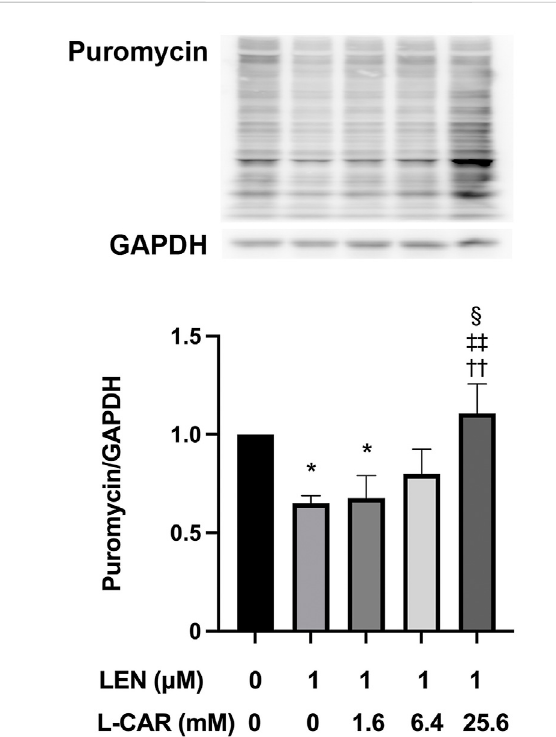
FIGURE 6 Effect of L-carnitine on protein synthesis in lenvatinib-treated C2C12 myocytes. The cells were treated with lenvatinib (1 µM), L-carnitine (1.6, 6.4, or 25.6 mM), or vehicle for 4 h. Thereafter, the rateof proteinsynthesis wasassessedusingtheSUnSETmethod. The upper panel represents the results, and the lower panel presents data as themean +SDofthree independentexperiments.* p < 0.05 vs . Ctrl group; †† p < 0.01 vs. LEN alone group; ‡‡ p < 0.01 vs. LEN +1.6 mM L-CARgroup; § p < 0.05vs.LEN+6.4 mM L-CARdosegroup.